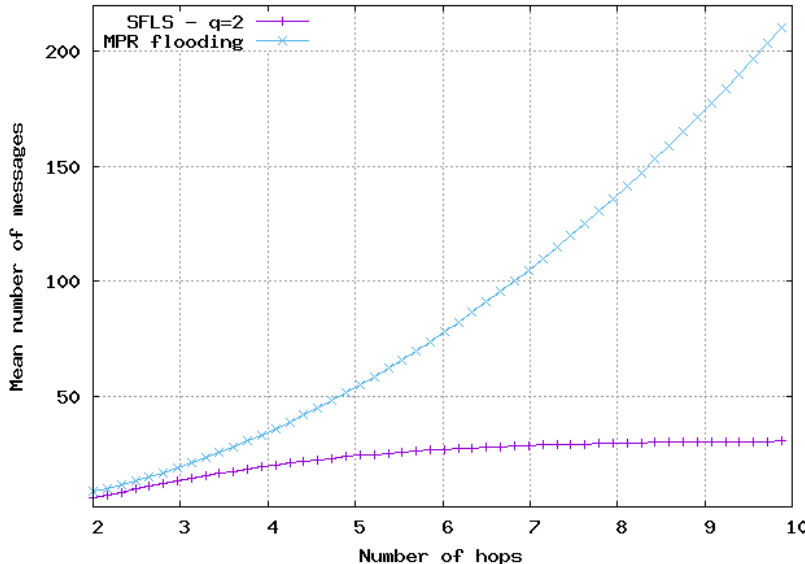
Figure 9. Mean number of messages sent for update with respect to number of hops in 2D homogeneous network, M = 10. Comparison of SFLS with the MPR flooding.